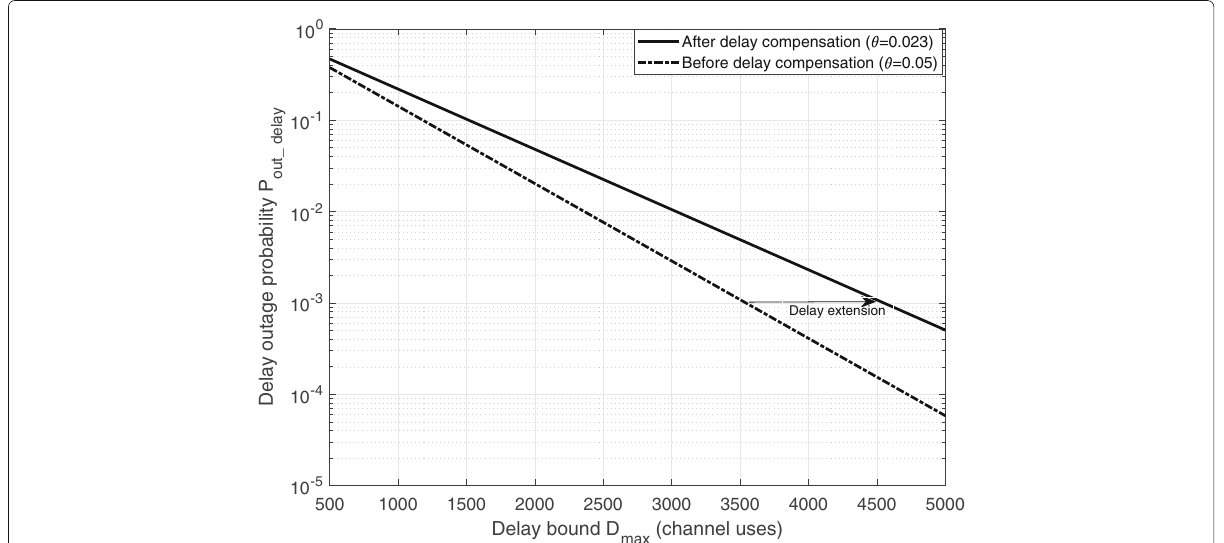
Fig. 7 Compensation via graceful degradation of delay constraint. Graceful degradation of delay constraint θ in case of five nodes colliding, where T f = 1000 and ρ = 1